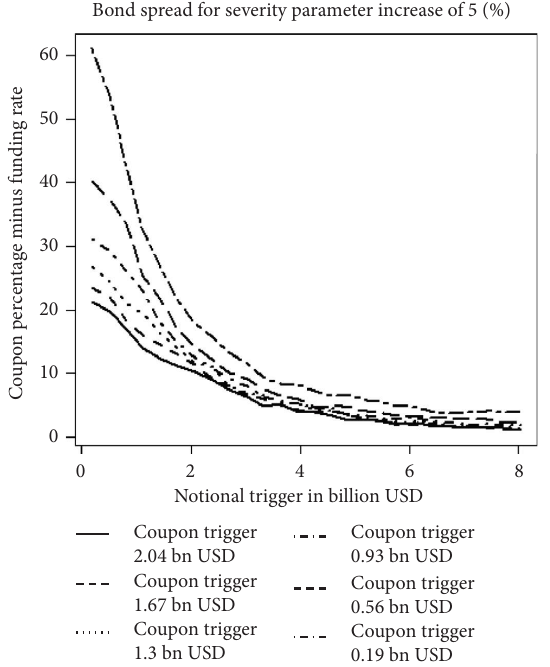
Figure 27: Cyber bond spread for loss severity parameter μ in- crease of 5%.